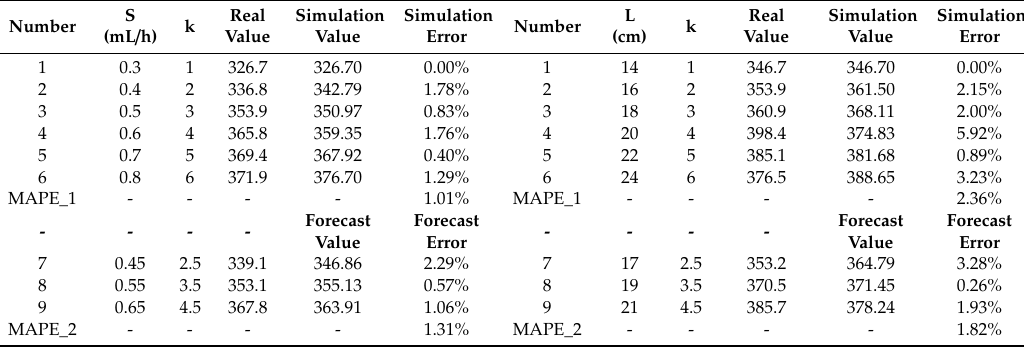
Table 3. Flow Rate (S) and Receiving Distance